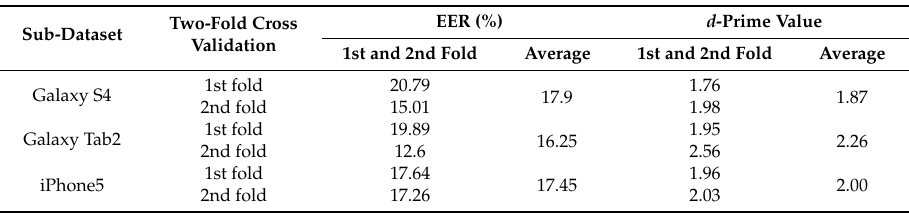
Table 7. EER and d -prime value of iris recognition in the three sub-datasets of the MICHE database including the data from indoors and